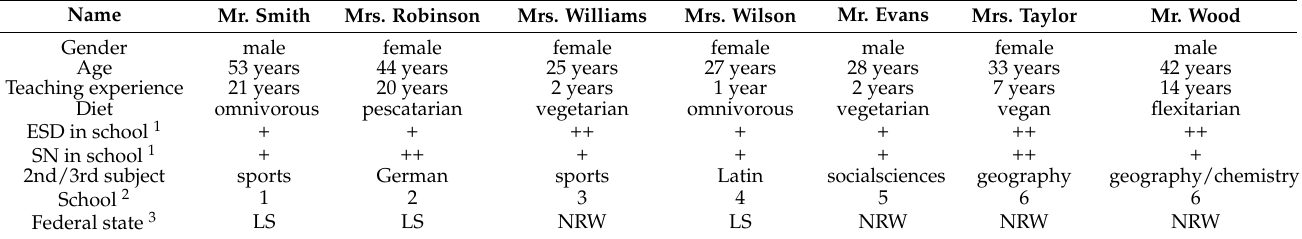
Table 1. Overview of the Biology Teacher Sample ( N =